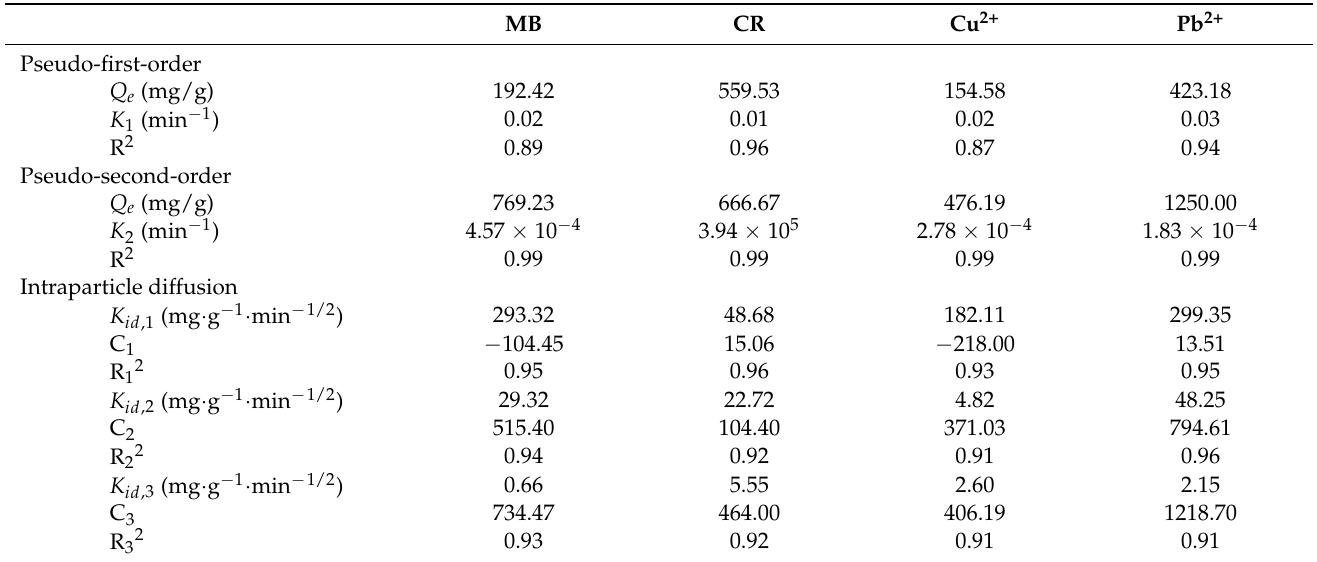
Table 2. Adsorption kinetics and intraparticle diffusion model parameters of UBC for metal ions and dyes.